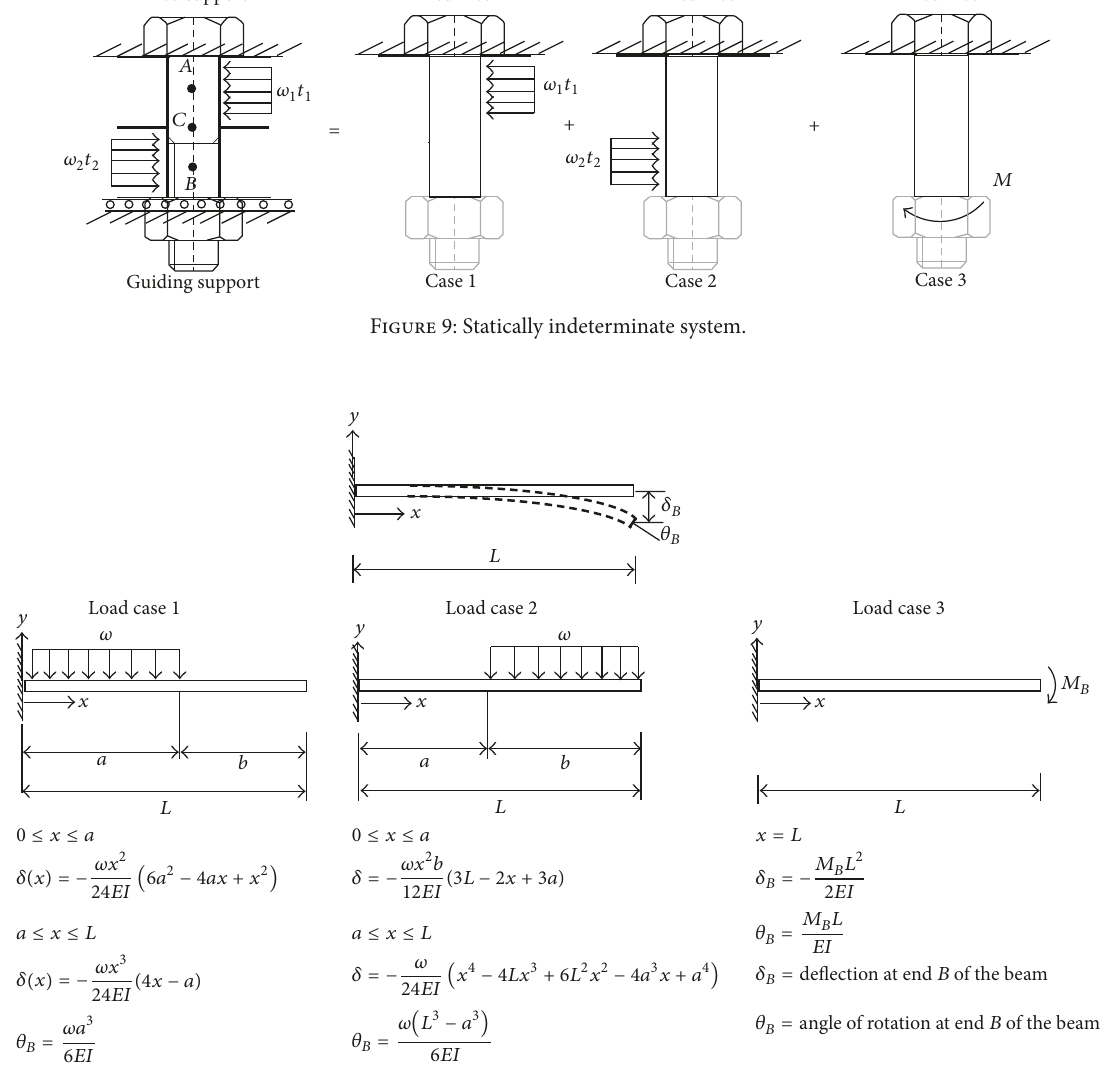
Figure 10: Bending deformation of cantilever